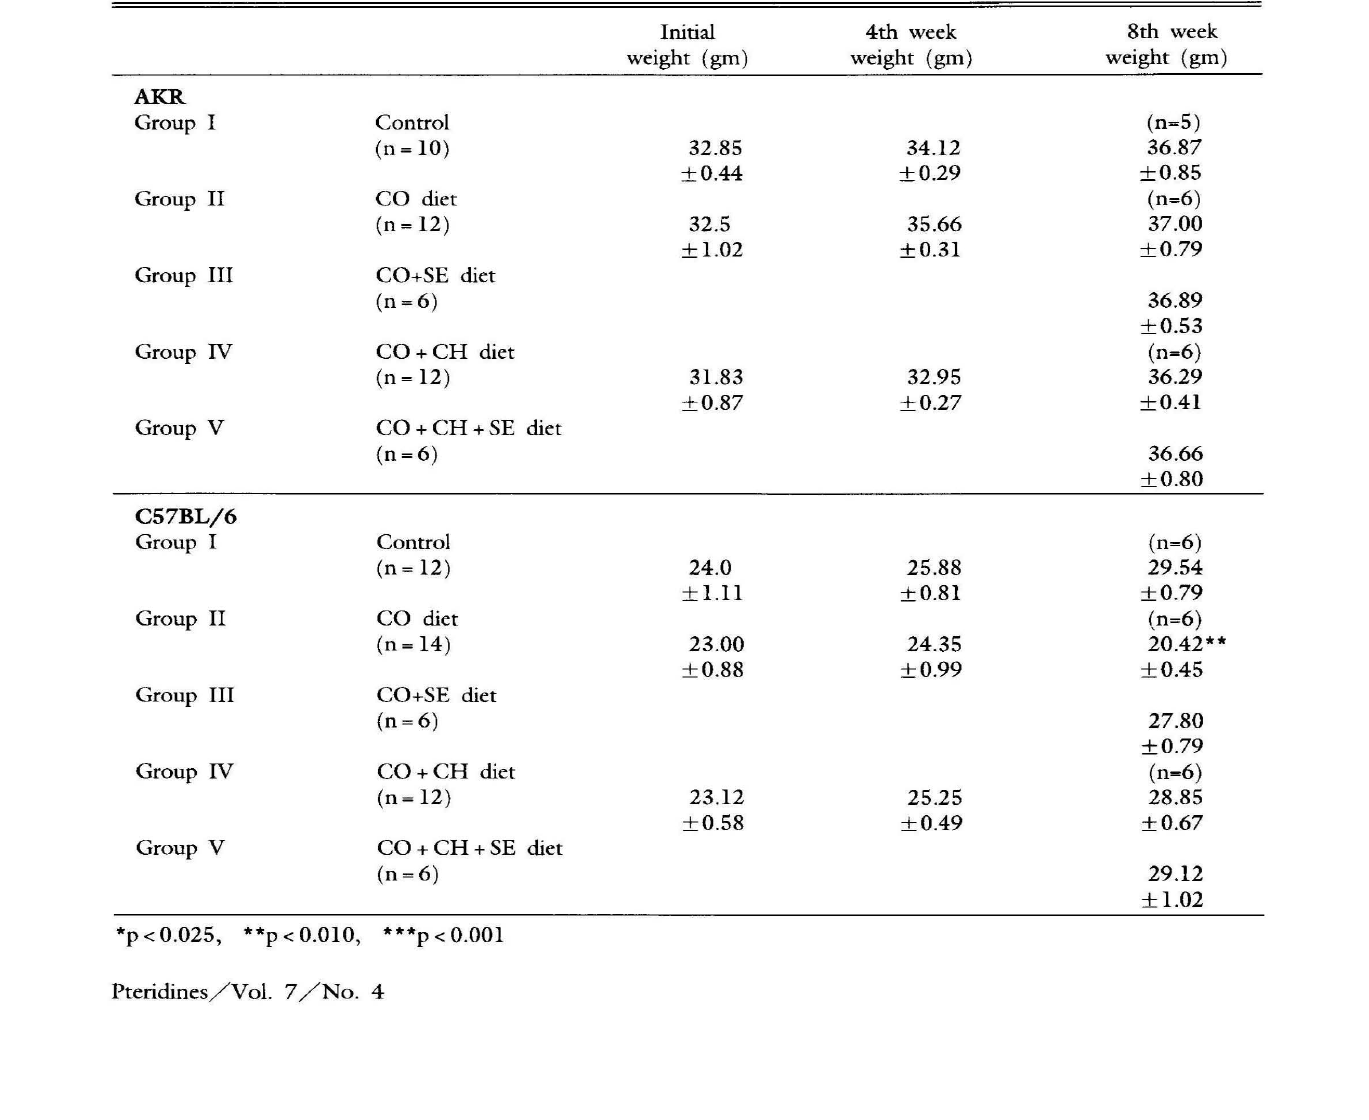
Table 4. Effect of dietary fat and cholesterol on growth (weight gain) in AKR & C57BL/ 6 strain of